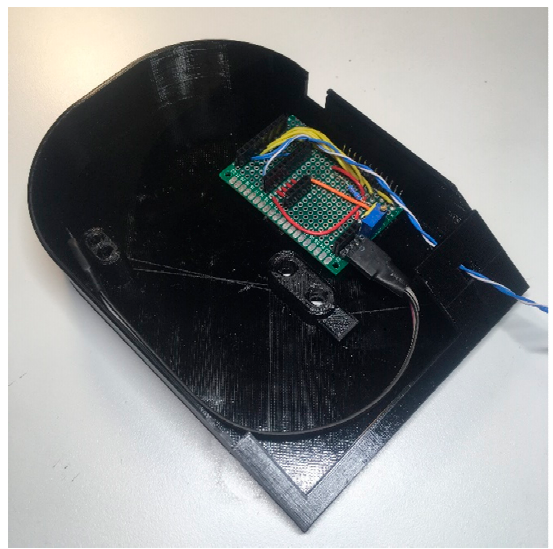
Figure 5. The circuit board fits into the bosses on the right side of the base to hold it in place. The twisted pair was fed through the hole for the push-button and a set of female–male jumper wires were connected to the load cell header pins to reach the TAL221 wires.